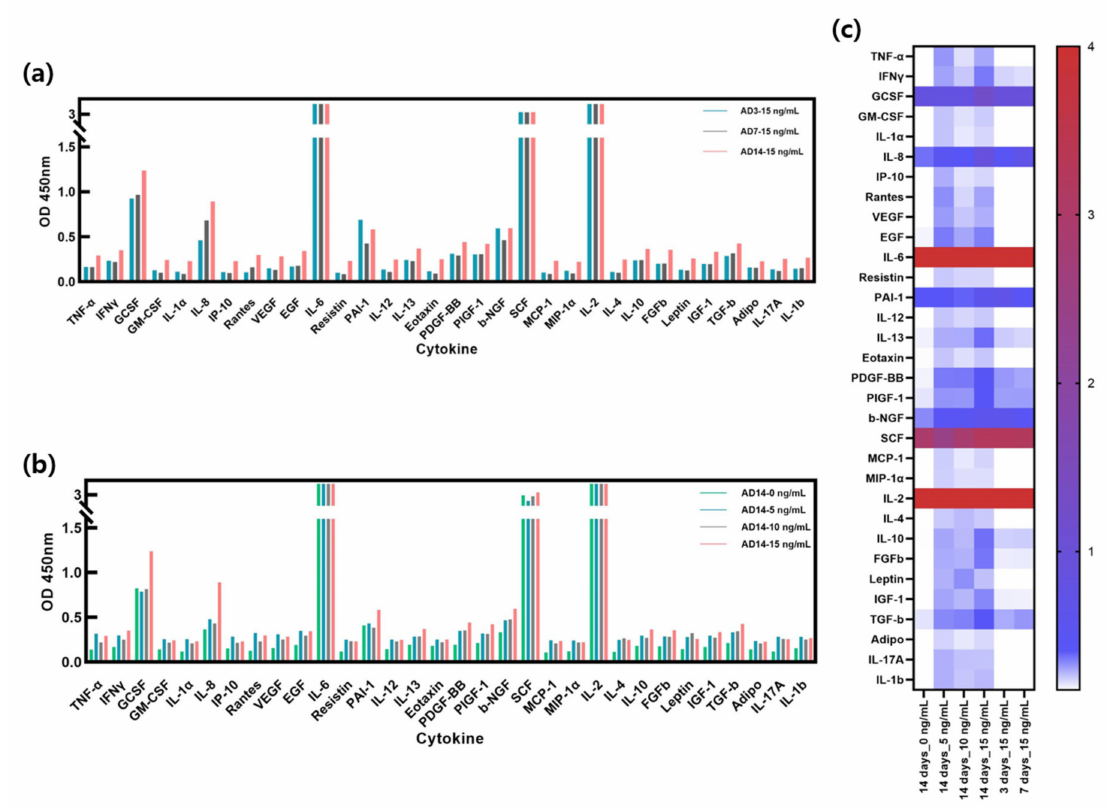
Figure 6. Cytokine expression in AD-HSE. ( a ) ELISA results with human cytokine plate array of AD-HSE stimulated with 15 ng/mL IL-4/IL-13 for 3, 7 and 14 days each. Most cytokines were highly expressed when AD-HSE was stimulated for 14 days. ( b ) ELISA results of AD-HSE stimulated with 0, 5, 10 and 15 ng/mL IL-4/IL-13 for 14 days, showing differential expression of cytokines depending on IL-4/IL-3 concentration. ( c ) The results of ELISAs shown by a heat